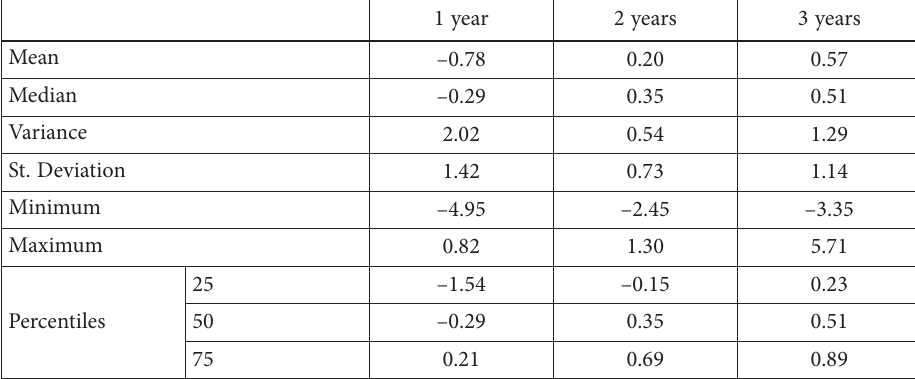
Table 8. Results of Index IN 05 (source: authors based on financial statements)